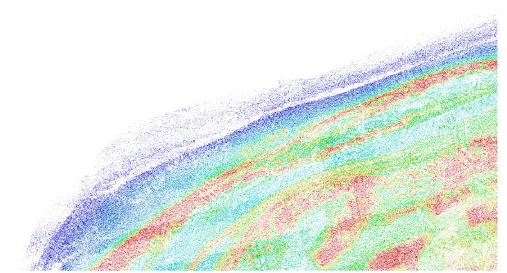
Figure 1: Visualization of a single point cloud tile stored in a LAS file. The colours indicate